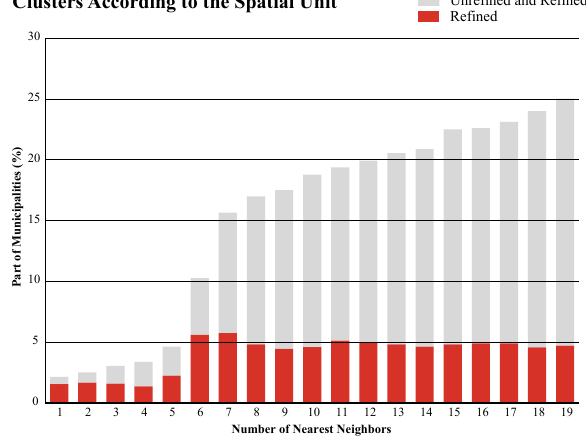
Figure 2. Proportion of municipalities with high-high and low- low residual clusters for the unrefined and refined